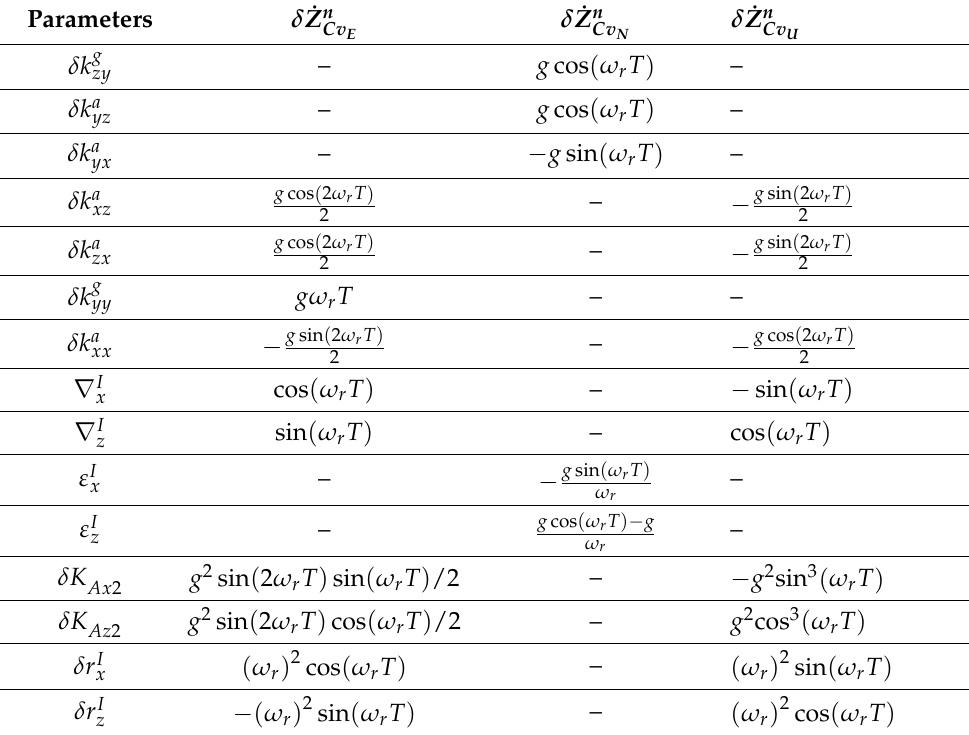
Table 1. Error propagation form of self-calibration parameters under transposition